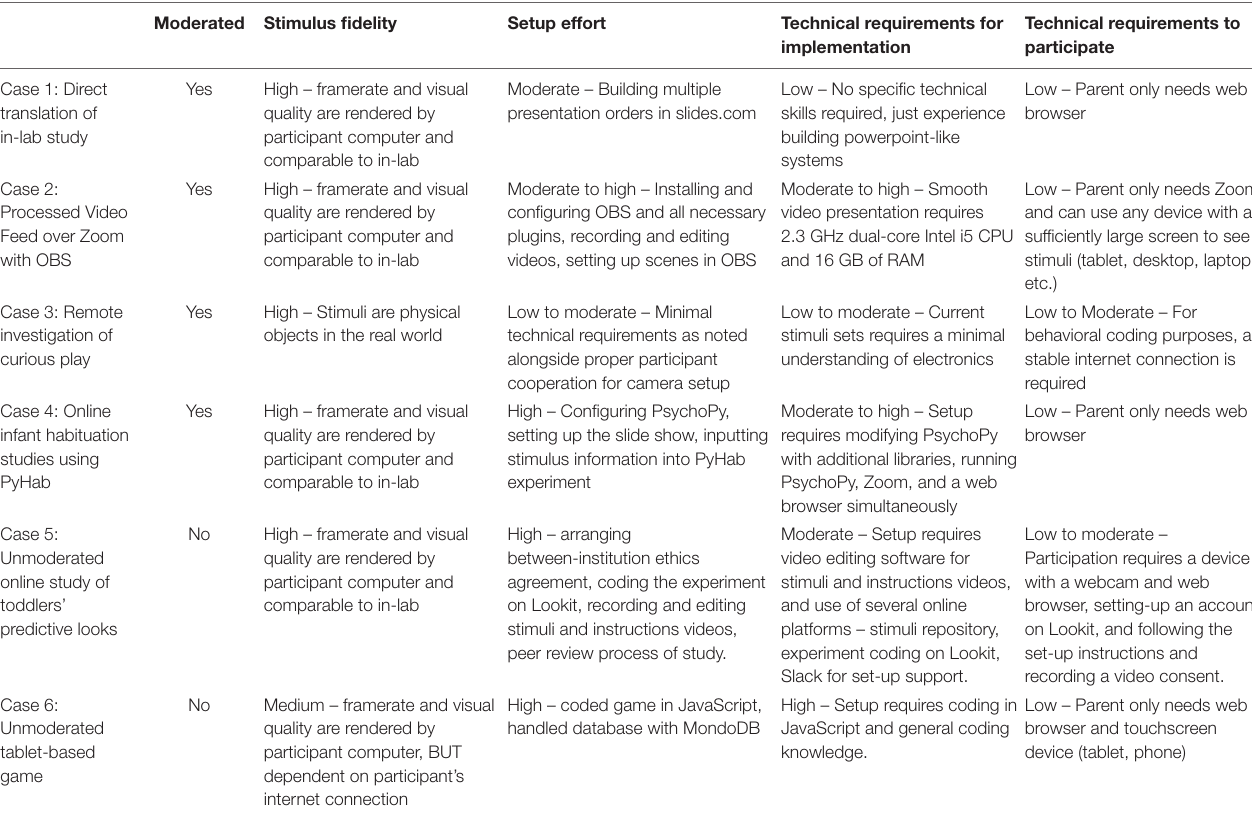
TABLE 1A | Features, advantages, and disadvantages of each of the six case